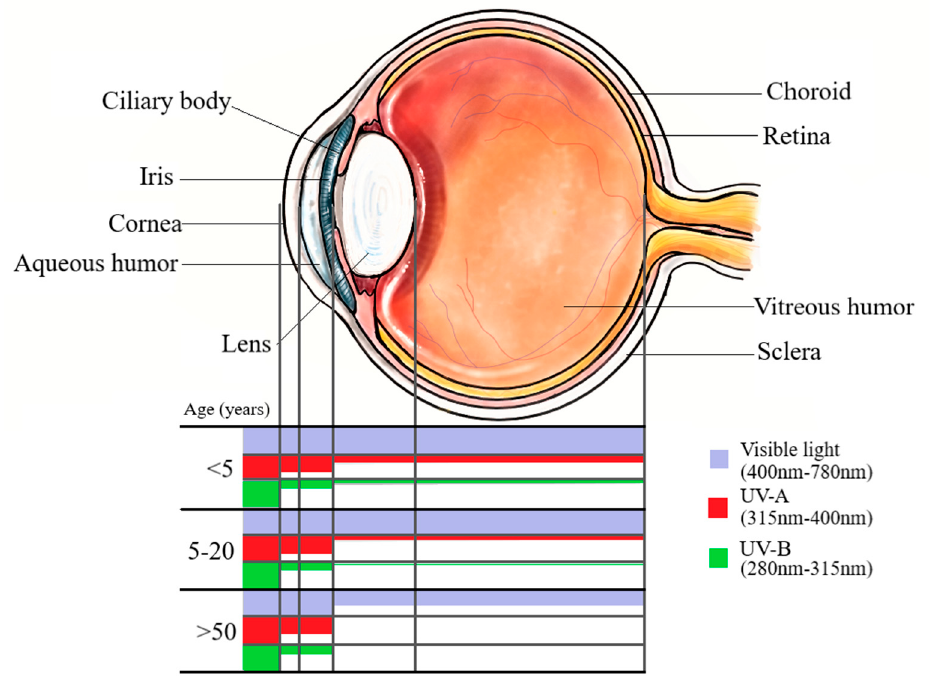
Figure 1. Transmission of UV wavelength spectra through ocular structures at different ages.